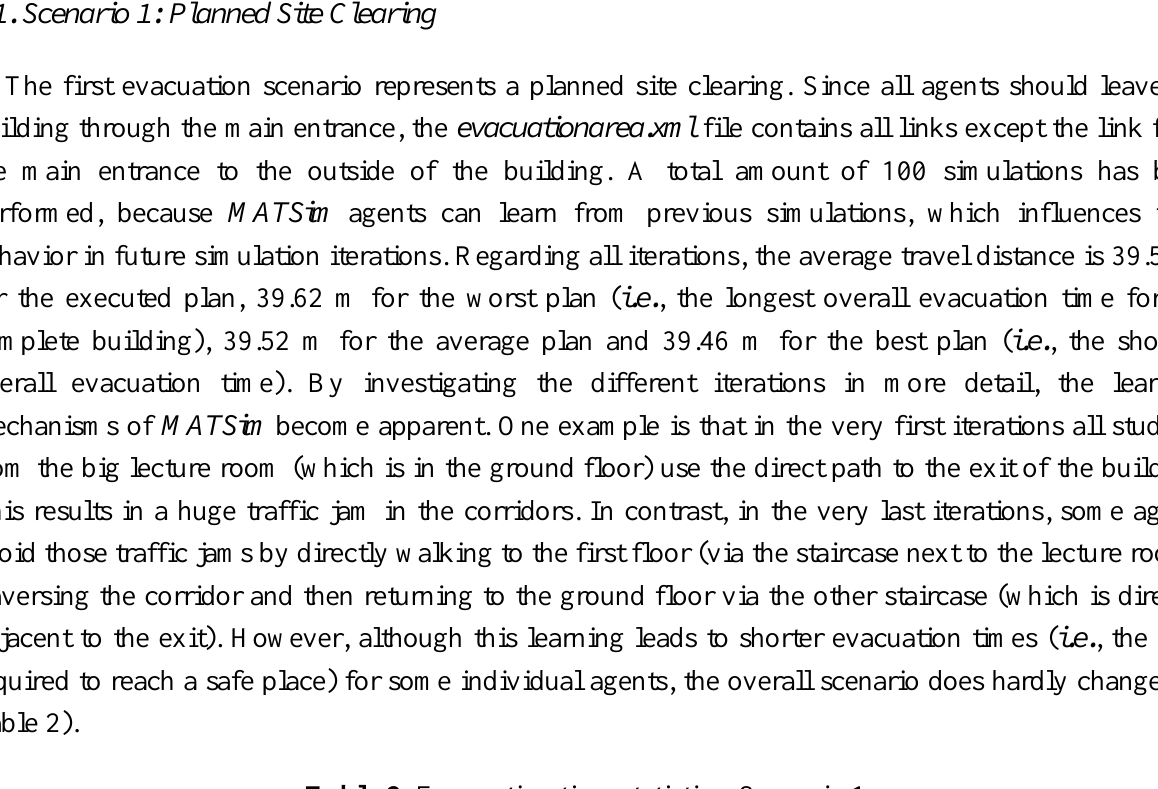
Table 2. Evacuation time statistics: Scenario 1.